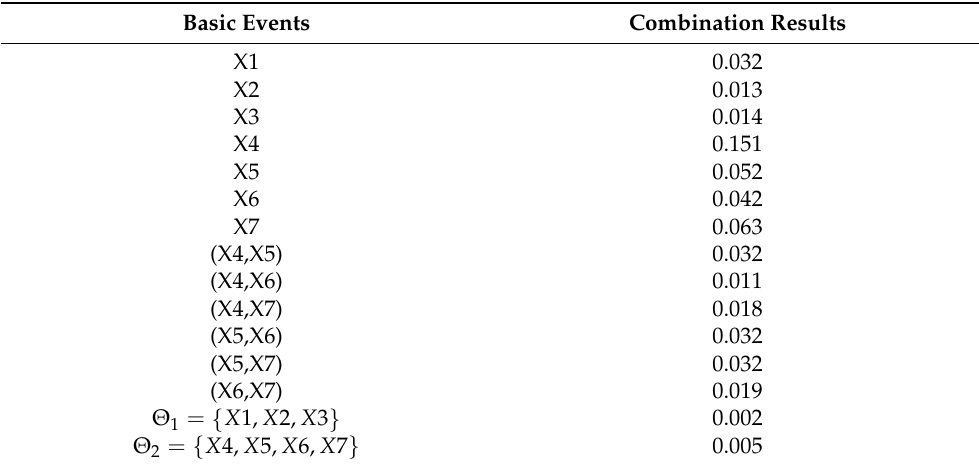
Table 4. Combination results of mass functions.